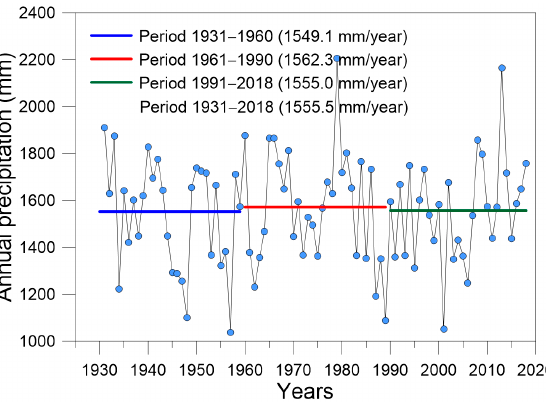
Figure 8. Annual precipitation with the values of the average annual precipitation for each of the Climatological Normals.